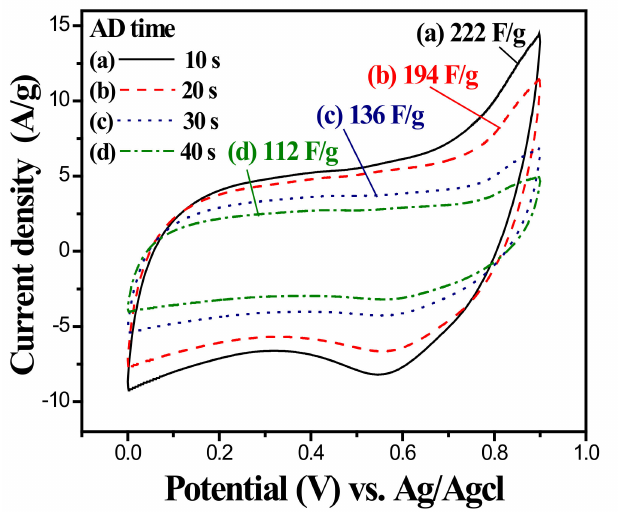
Figure 8. Cyclic voltammograms of MnOx-coated ZnO nanorod measured from the 50th cycle in 1.0 M Na 2 SO 4 electrolyte at a scan rate of 25 mV / s as a function of anodic deposition time. The MnOx was coated in a 0.25 M Mn(CH 3 COO) 2 · 4H 2 O solution at 25 ◦